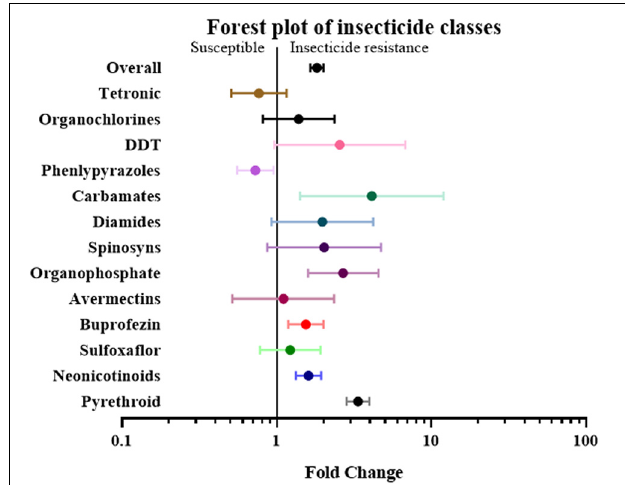
FIGURE 2 | Meta-analytical, sub-group estimate of gene expression related to insecticide resistance, with 95% CI in the P450, GST, and esterase gene families. The overall effect represents the collective effect of all the studies in terms of their unweighted analyses.